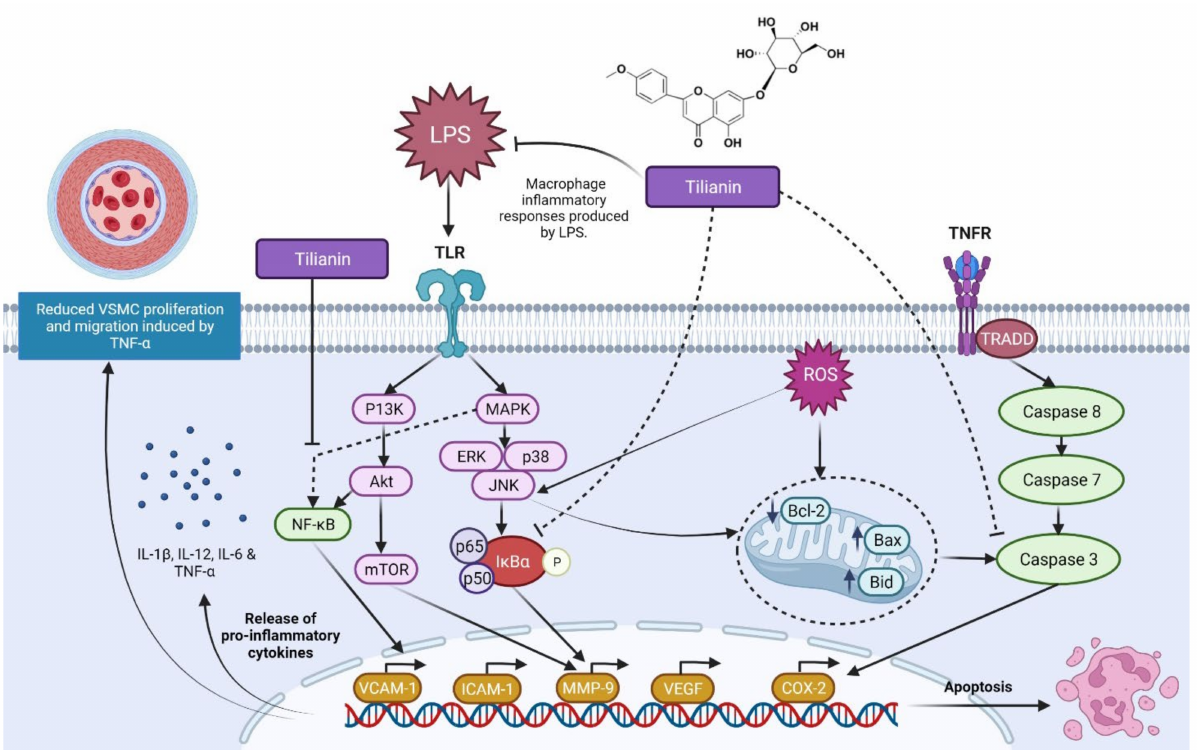
Figure 5. Possible mechanism of action of tilianin against atherosclerosis [29,30]. Tilianin inhibits the activation of NF- κ B, as well as the activation, phosphorylation and degradation of IkB kinase. This bioactive compound also inhibits TNF-induced VSMC proliferation and migration while lower- ing LPS-induced macrophage inflammation. Abbreviations: TLR, Toll-like receptor; TNFR, Tumor necrosis factor receptor; MAPK, Mitogen-activated protein kinase; P13K, Phosphatidylinositol-3- Kinase; ERK, Extracellular signal-regulated kinase; JNK, c-Jun N-terminal kinases; I κ B α , Nuclear factor of kappa light polypeptide gene enhancer in B-cells inhibitor alpha; Akt, Ak strain trans- forming; NF- κ B, Nuclear factor kappa-light-chain-enhancer of activated B cells; mTOR, Mammalian target of rapamycin; VCAM-1, Vascular cell adhesion protein 1; ICAM-1, Intercellular Adhesion Molecule 1; MMP-9, Matrix metallopeptidase 9; VEGF, Vascular endothelial growth factor; COX-2, Cyclooxygenase-2; Bcl-2, B-cell lymphoma 2; Bax, Bcl-2 Associated X-protein; Bid, BH3 interacting- domain death agonist; IL-1 β , -12, -6, Interleukin-1 beta,-12,-6; TNF- α , Tumour necrosis factor alpha; VSMC, Vascular smooth muscle